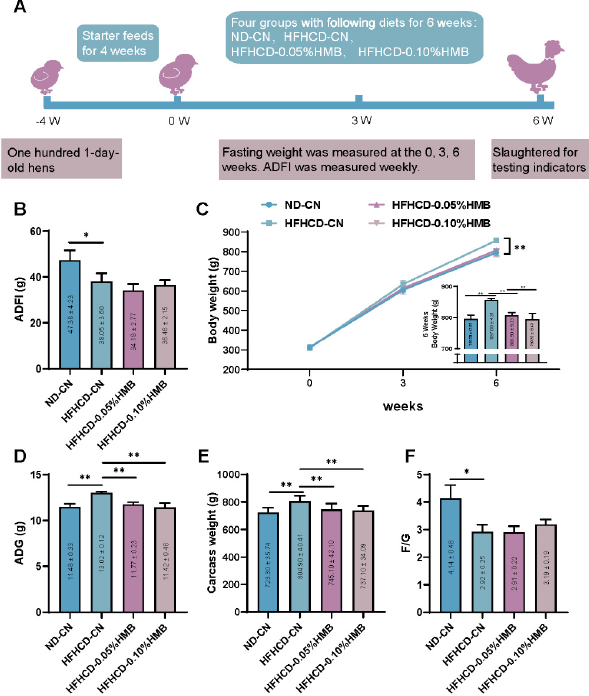
Figure 1. Effects of HMB supplementation on the growth performances of HFHCD − challenged layers. ( A ) Diagram of the experimental design. ( B ) Average daily feed intake. ( C ) Bodyweight curve of the growing hens. ( D ) Average daily gain weight. ( E ) Carcass weight of the growing hens ( F ) Feed-to-gain ratio of the growing hens. All the results are shown as the means ± SDs; n = 3; * p < 0.05, ** p < 0.01.